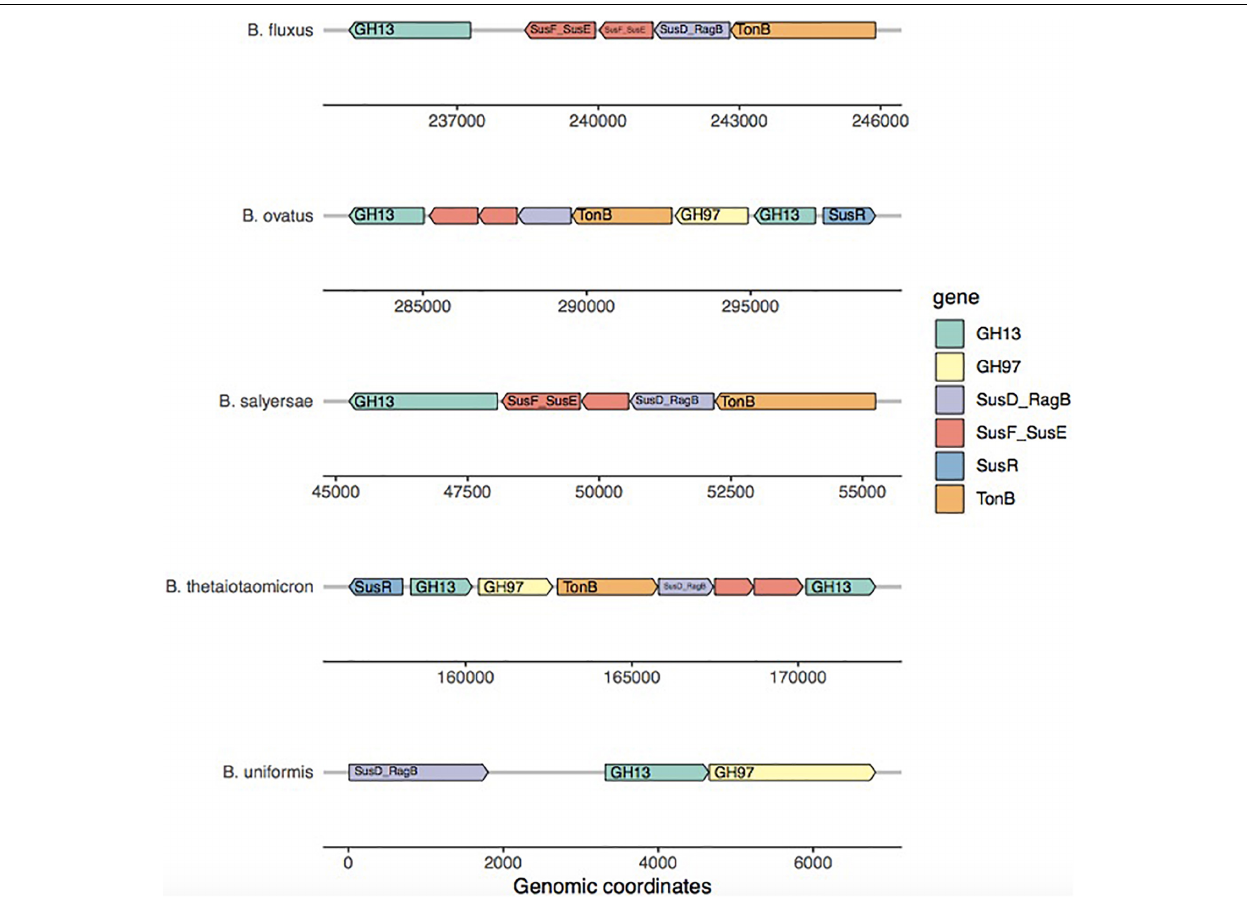
FIGURE 5 | Amylase PUL visualization across five Bacteroides genomes. For each strain, only the most complete PUL is represented. The reference to build the starch model came from Bacteroides thetaiotaomicron . This representation highlights the lack of synteny of the starch PUL within the genomes of strains belonging to the same